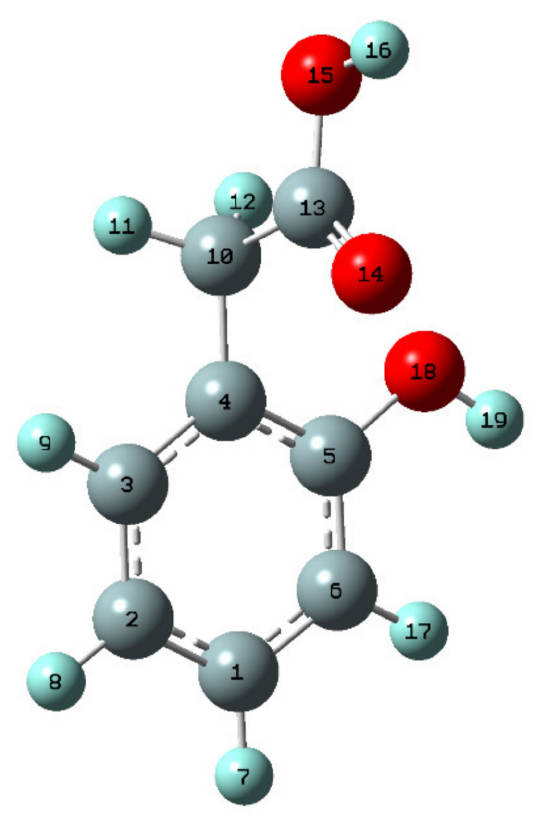
Figure 2. Chemical structure of 2-hydroxyphenylacetic acid